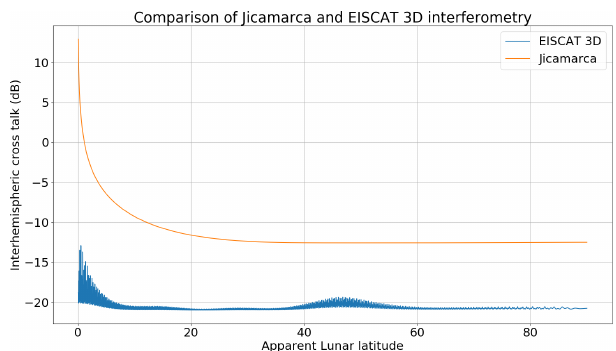
Figure 3. Due to uncertainties in the disambiguation calculation, a band surrounding the Doppler equator is poorly resolved. Note that the map is reprojected from range and Doppler coordinates to se- lenographic coordinates. Near the Doppler equator, features become lost in noise due to the noise-enhancing effects of poor disambigua- tion. This figure is produced from the same data as Vierinen et al. (2017b).